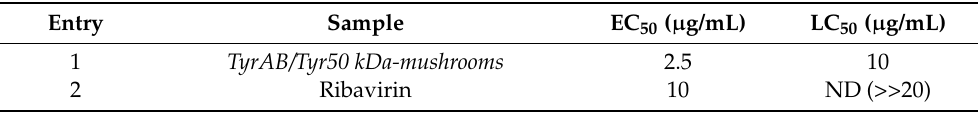
Table 2. EC 50 and LC 50 of the enzyme solution obtained directly from mushroom compared with